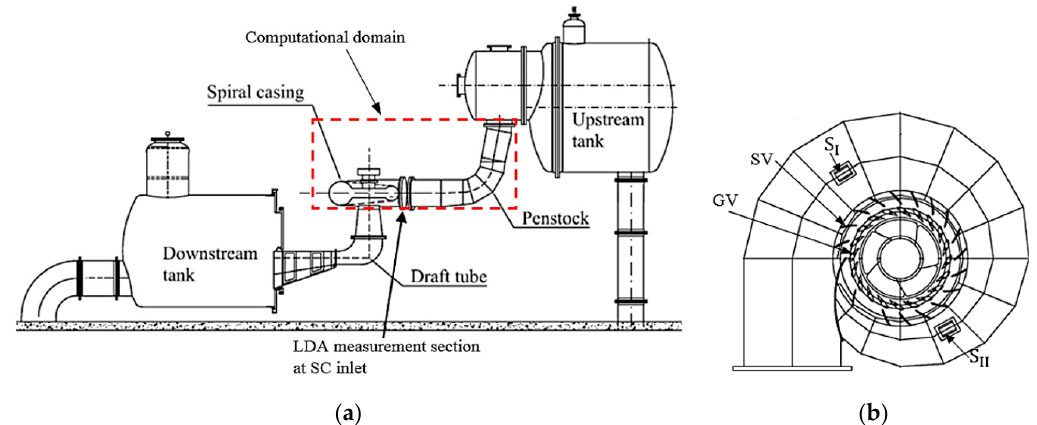
Figure 1. ( a ) Porjus U9 test rig facility with the computational domain marked by the dashed-rectangle; ( b ) top view of the turbine with laser Doppler anemometry (LDA) measurement locations: S I and S II from Mulu and Cervantes [27].